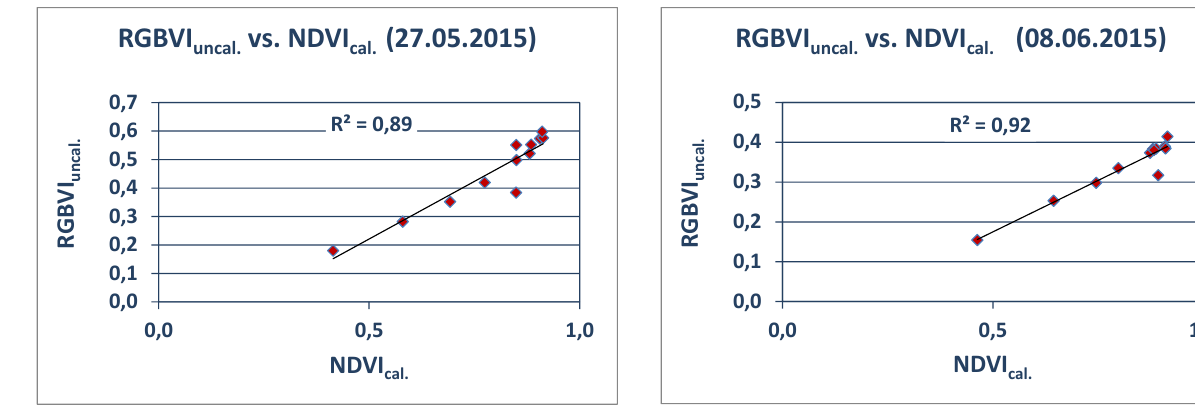
Figure 6. Evaluation of the RGBVI uncal. vs. NDVI cal. for the N experiment for May 27 th , 2015